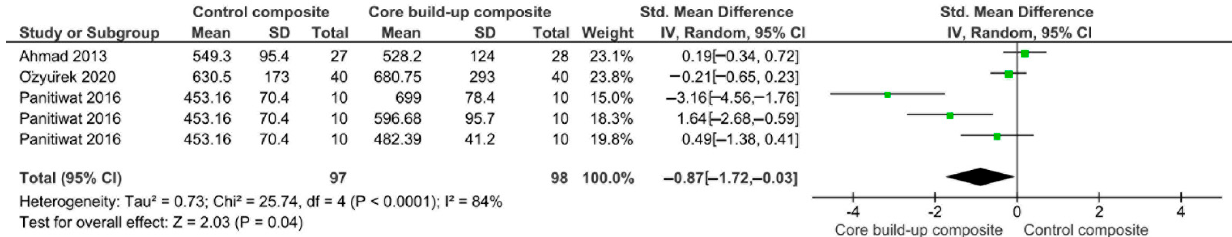
Figure 2. Results of the meta-analysis of the fracture strength of endodontically treated teeth, restored with a core-build up composite or a conventional composite. Fracture strength was higher when the endodontically treated teeth were restored with a core-build up composite ( p = 0.04).